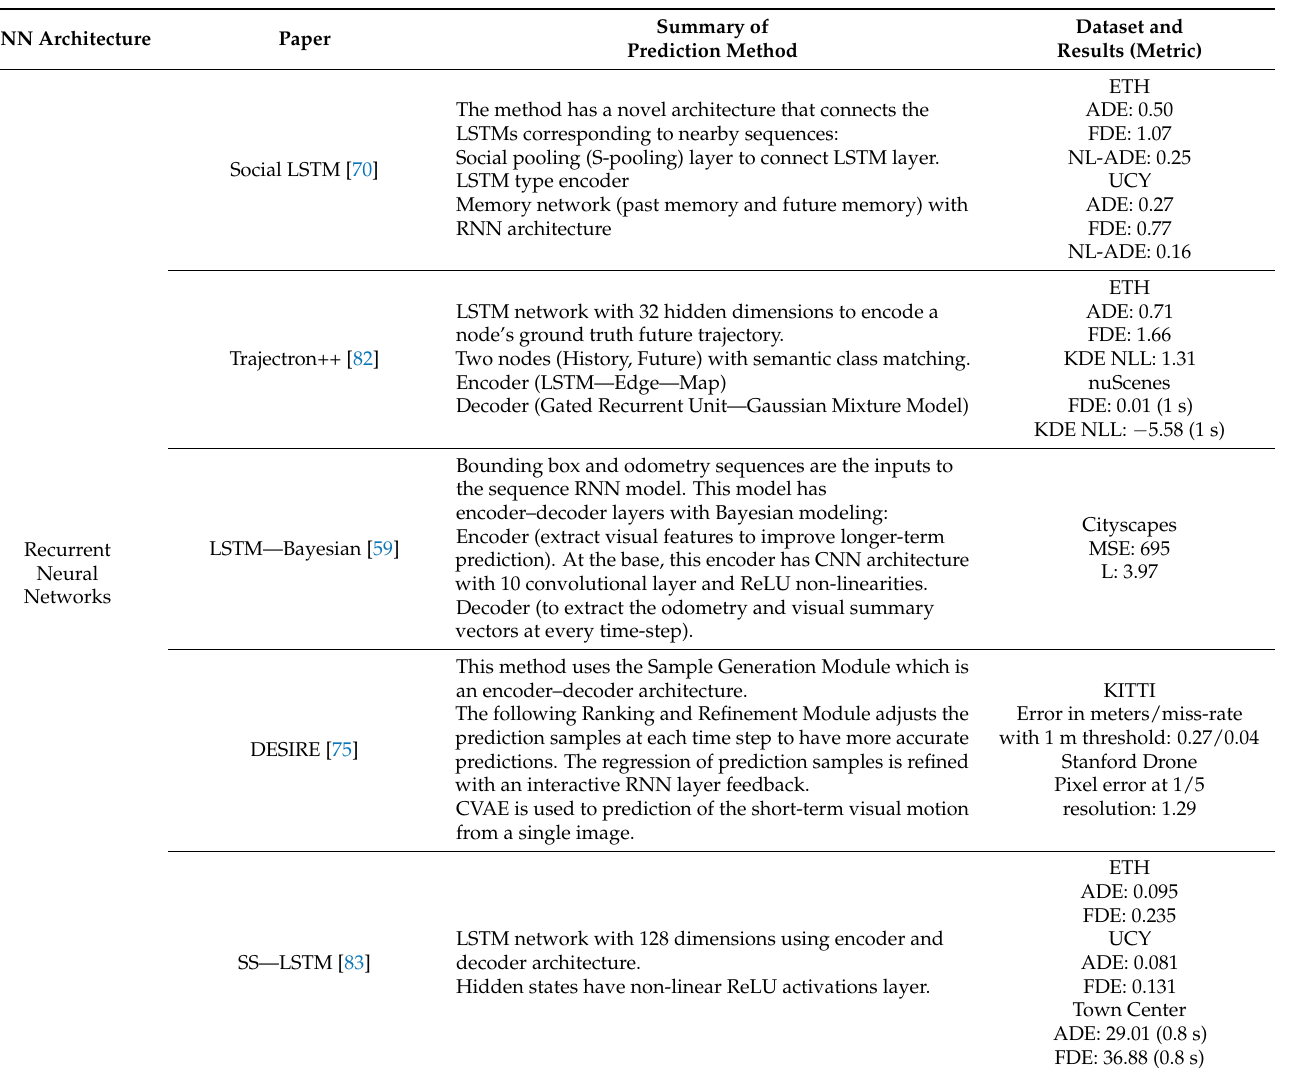
Table 2. Classification of the most relative pedestrian trajectory prediction solutions, detailing prediction methods and the results.